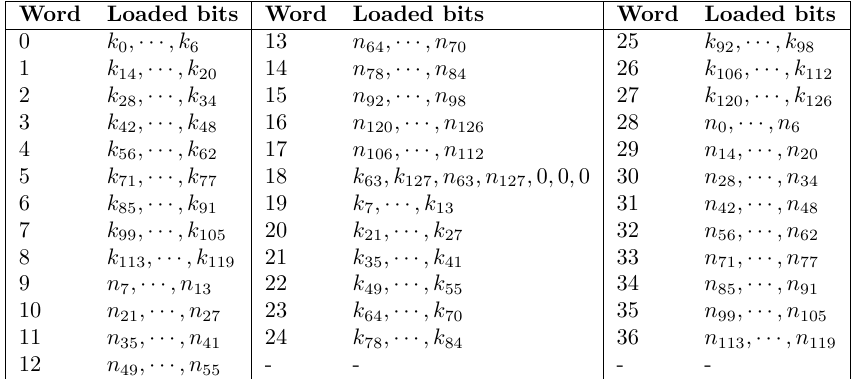
Table 13: The load ( N, K ) procedure of WAGE - AE -128